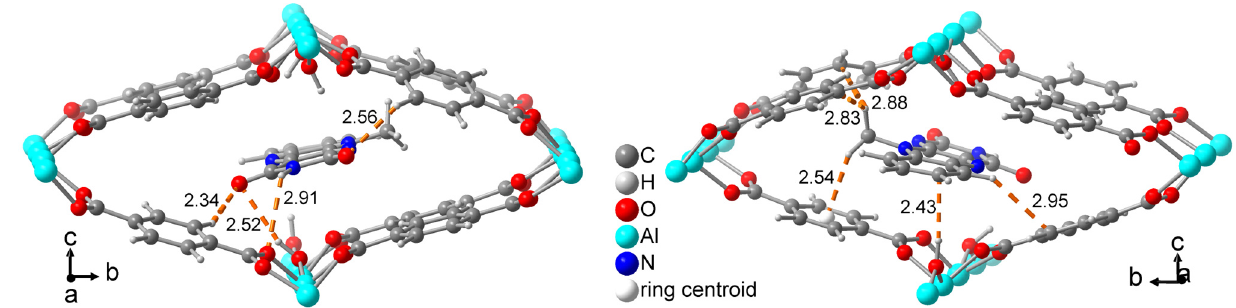
Figure 8. Computed structure of MIA@MIL ‐ 53 viewed from both ends of the MIA molecule with indication of the weak C-H ··· O, C-H ··· π , C-H ··· C, N-H ··· O, O-H ··· O and O-H ··· C interactions (H ··· X indication of the weak C ‐ H ∙∙∙ O, C ‐ H ∙∙∙π , C ‐ H ∙∙∙ C, N ‐ H ∙∙∙ O, O ‐ H ∙∙∙ O and O ‐ H ∙∙∙ C interactions (H ∙∙∙ X distances in Å, distances above 3 Å are not distances in Å, distances above 3 Å are not shown).